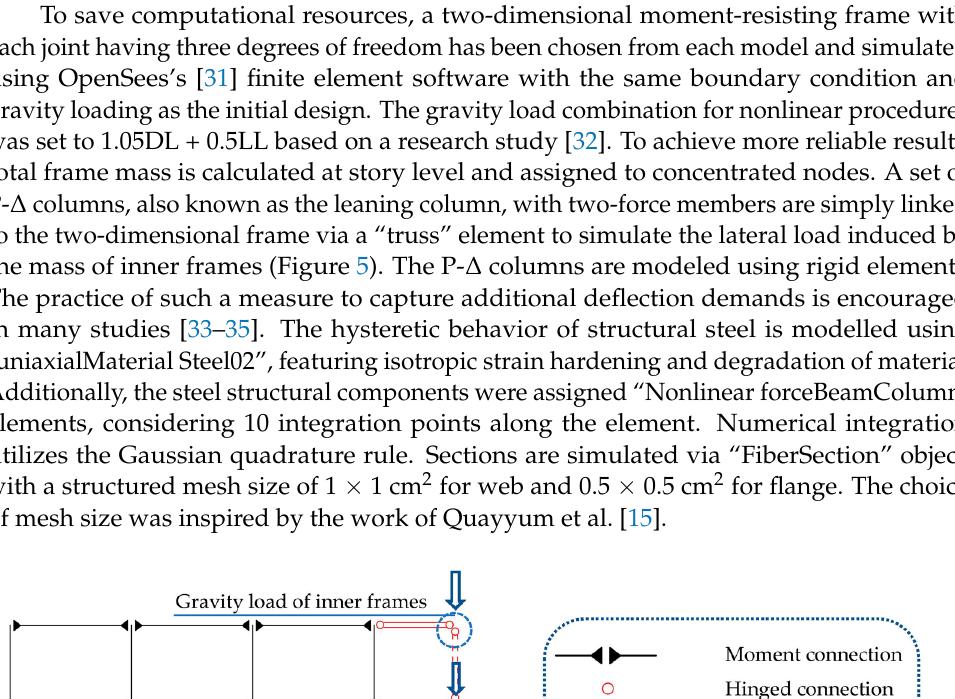
Table 3. Specification of PGA and PGV for record sets.